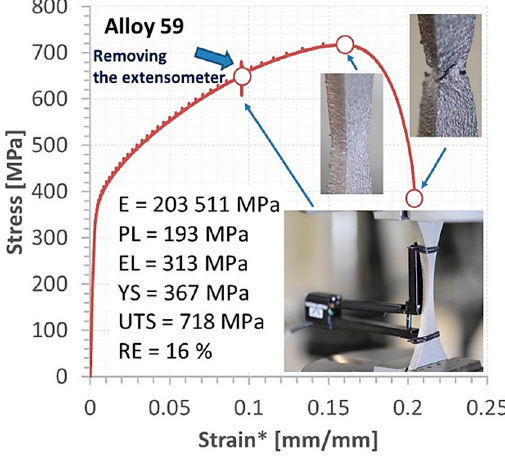
Figure 12. Stress–strain curve of the Alloy 59, *—strain determined based on data from Figure 11 and values of displacement.